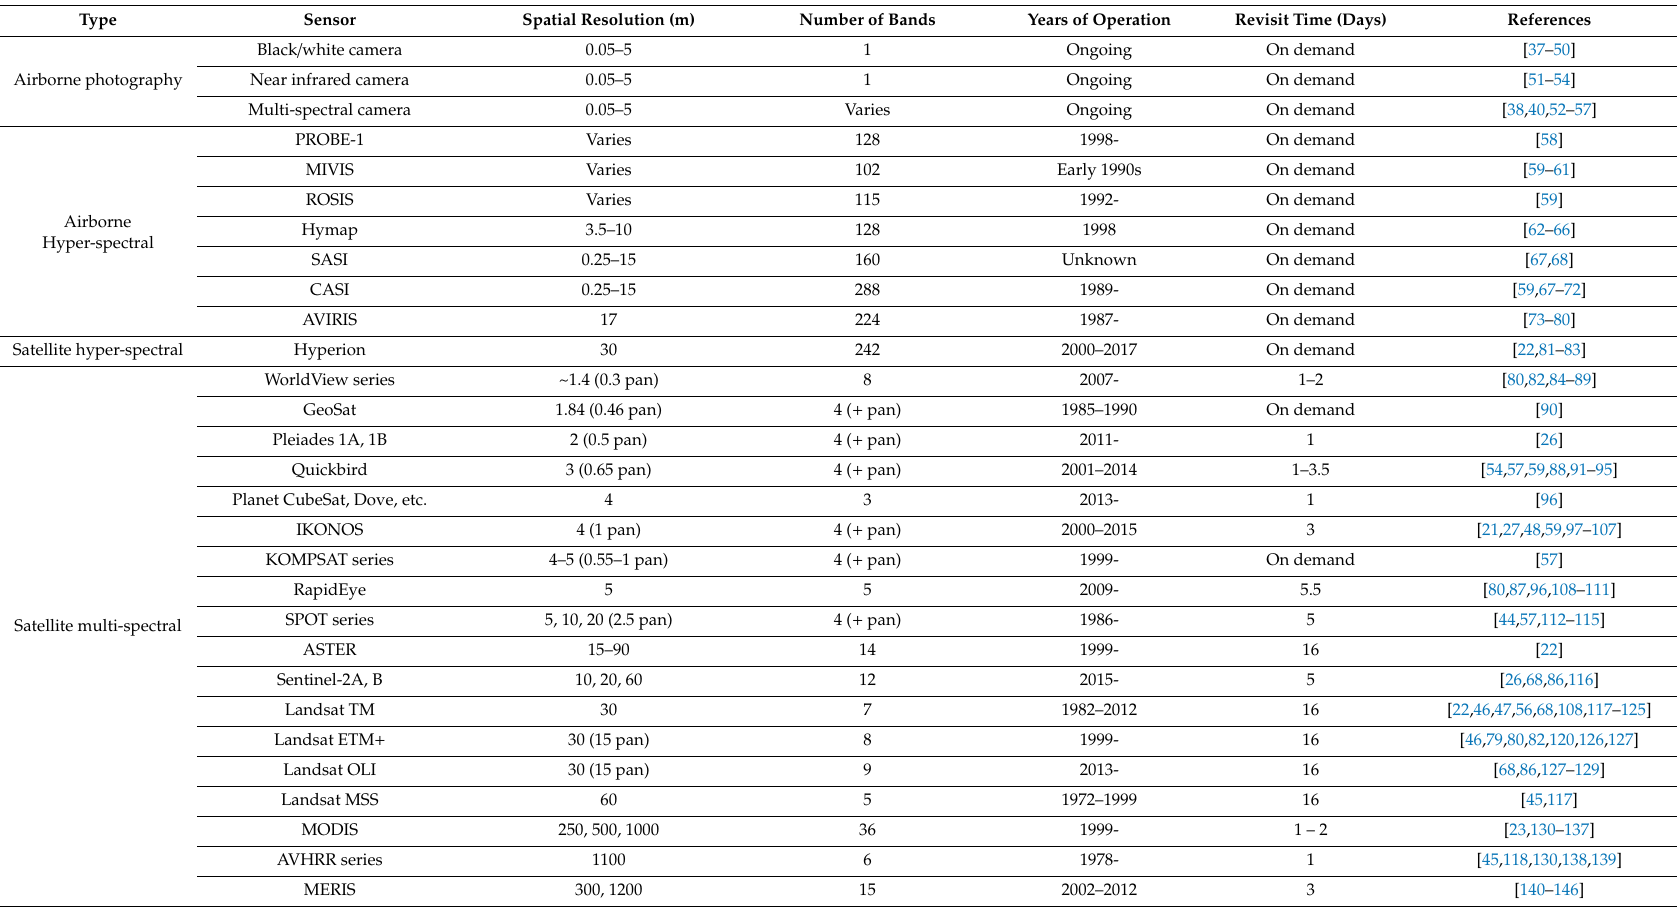
Table 1. Current (and future) remote sensing technologies used for mapping wetlands, ranked from high to low spectral resolution per class from 178 peer reviewed journal articles. Pan = panchromatic